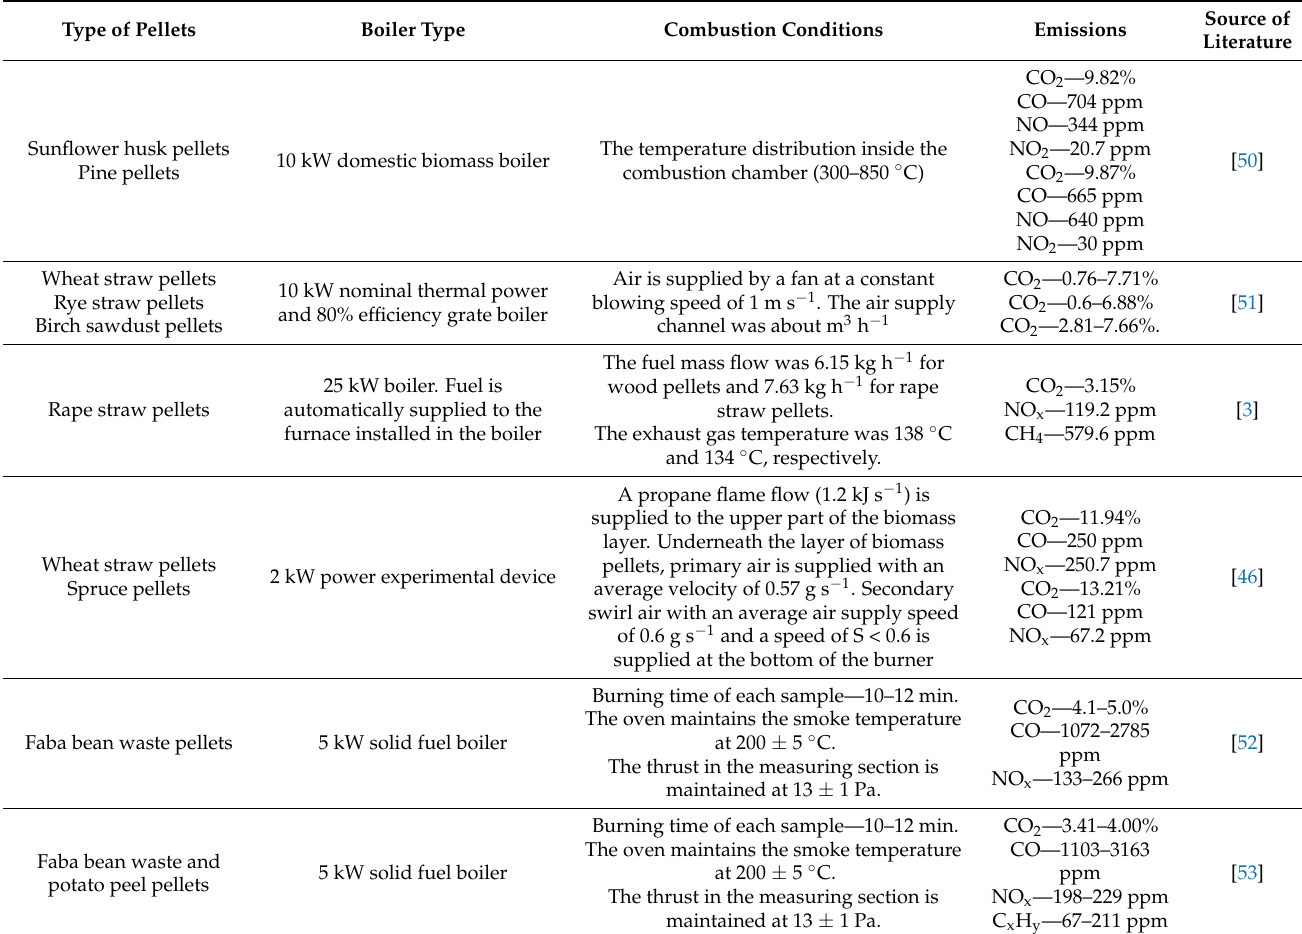
Table 5. Harmful emissions from burning biomass under different